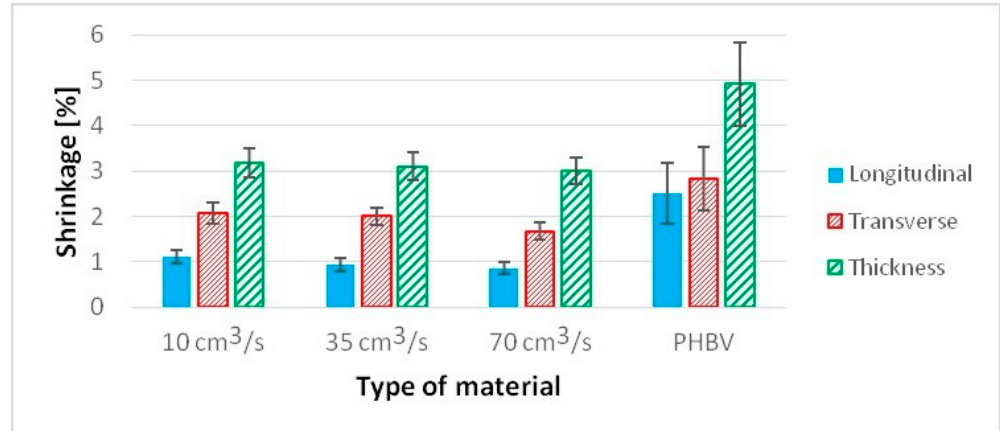
Figure 10. Linear shrinkage of samples produced at a variable injection rate compared to a pure PHBV sample produced at 35 cm 3 /s: longitudinal, transverse, in thickness.